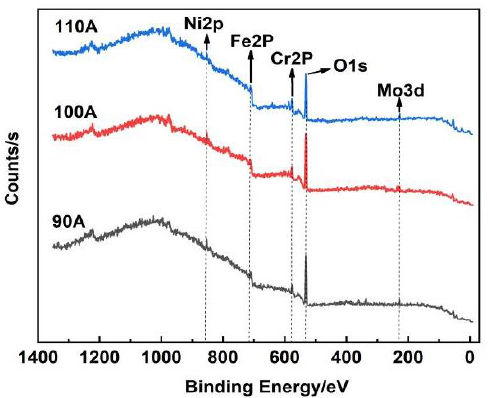
Figure 9. XPS spectra of passive film on the surface of 2205 DSS cladding layer after passivation for 2 h at 0.3 VSCE in 3.5% NaCl solutions.